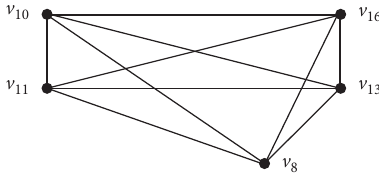
Figure 6: Clique of graph G